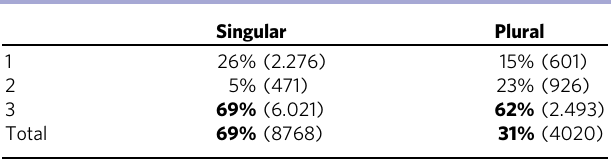
Table 1 Person – number frequencies in the oral subcorpus of the